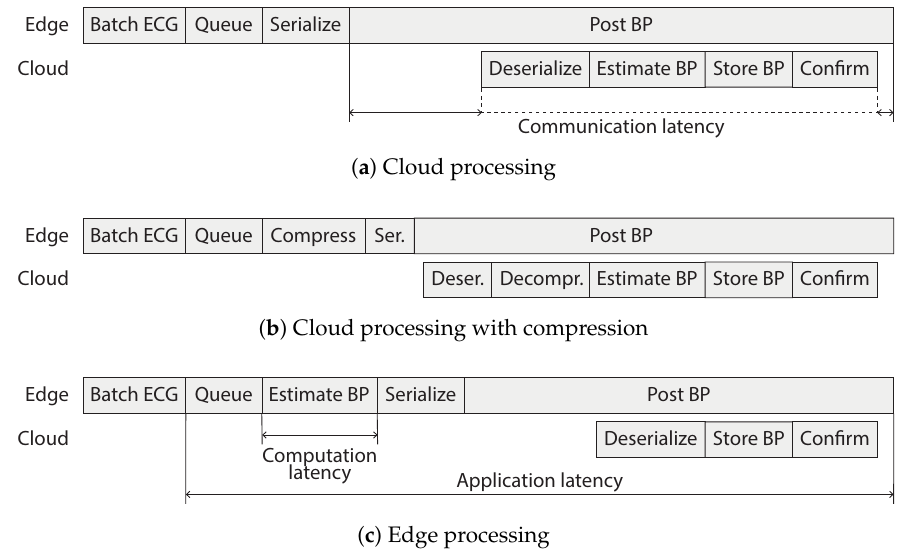
Figure 3. An overview of time-related metrics annotated on timelines that show the most significant steps in the application for the three different